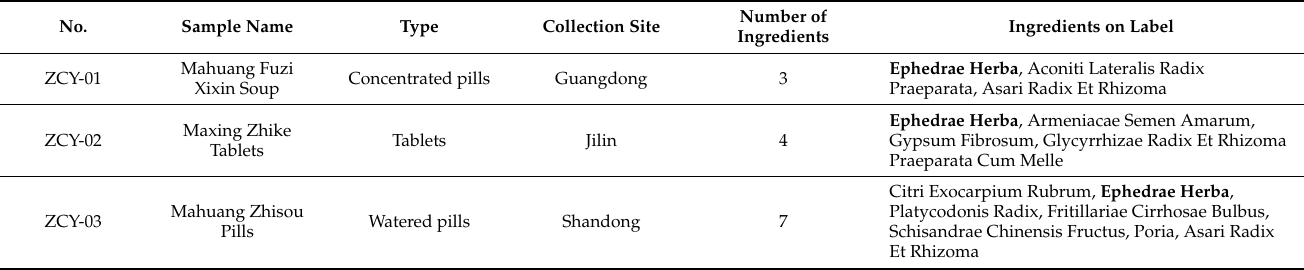
Table 2. Detailed information of the seven batches of Chinese patent